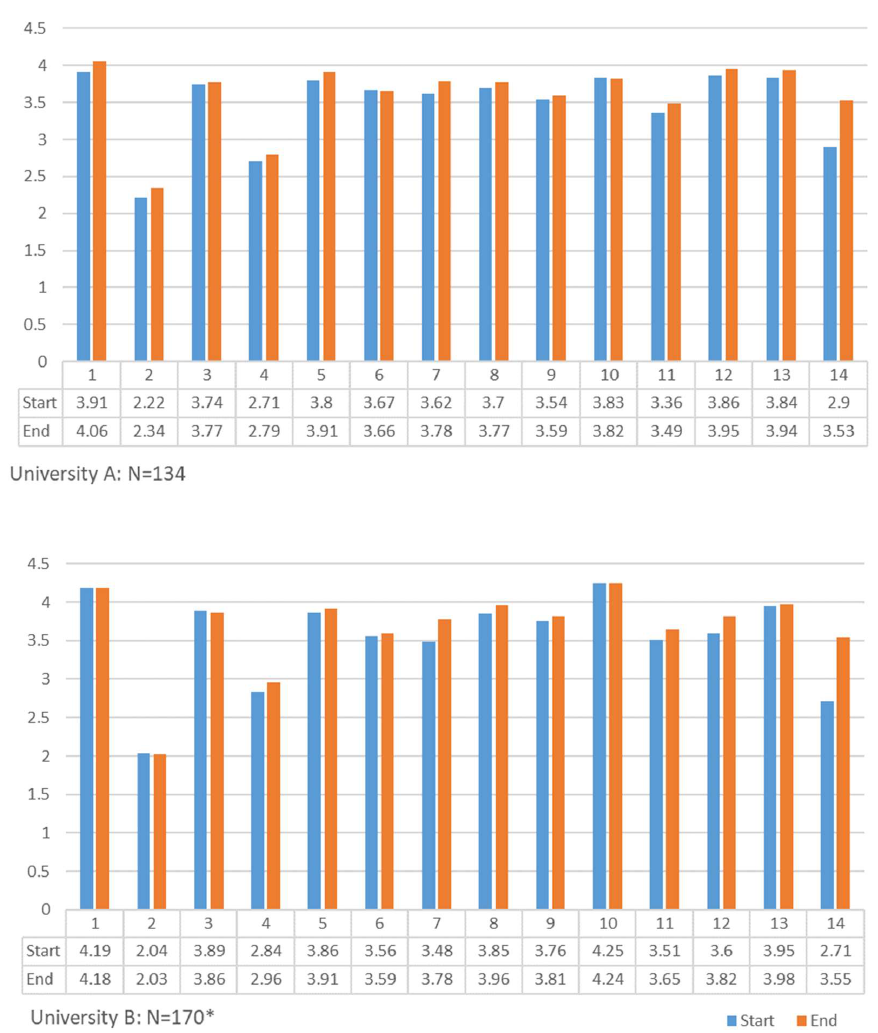
Figure 2. Entrepreneurship composite competencies (self-)assessed by students at the Start and End of the EE intervention: 1—Metacognition; 2—Growth Mindset; 3—Coping with Emotions; 4—Autonomous Motivation; 5—Problem-Solving; 6—Planning; 7—Ethics and Sustainability**; 8—Creativity; 9—Personal Initiative; 10—Cooperation; 11—Business Opportunities**; 12—Environment**; 13—Financial Literacy; 14—Entrepreneurial Process**. Note: * For Entrepreneurial Process competencies N = 132; ** Impact patterns’ similarity/overlap at universities A and B ( p < 0.05).